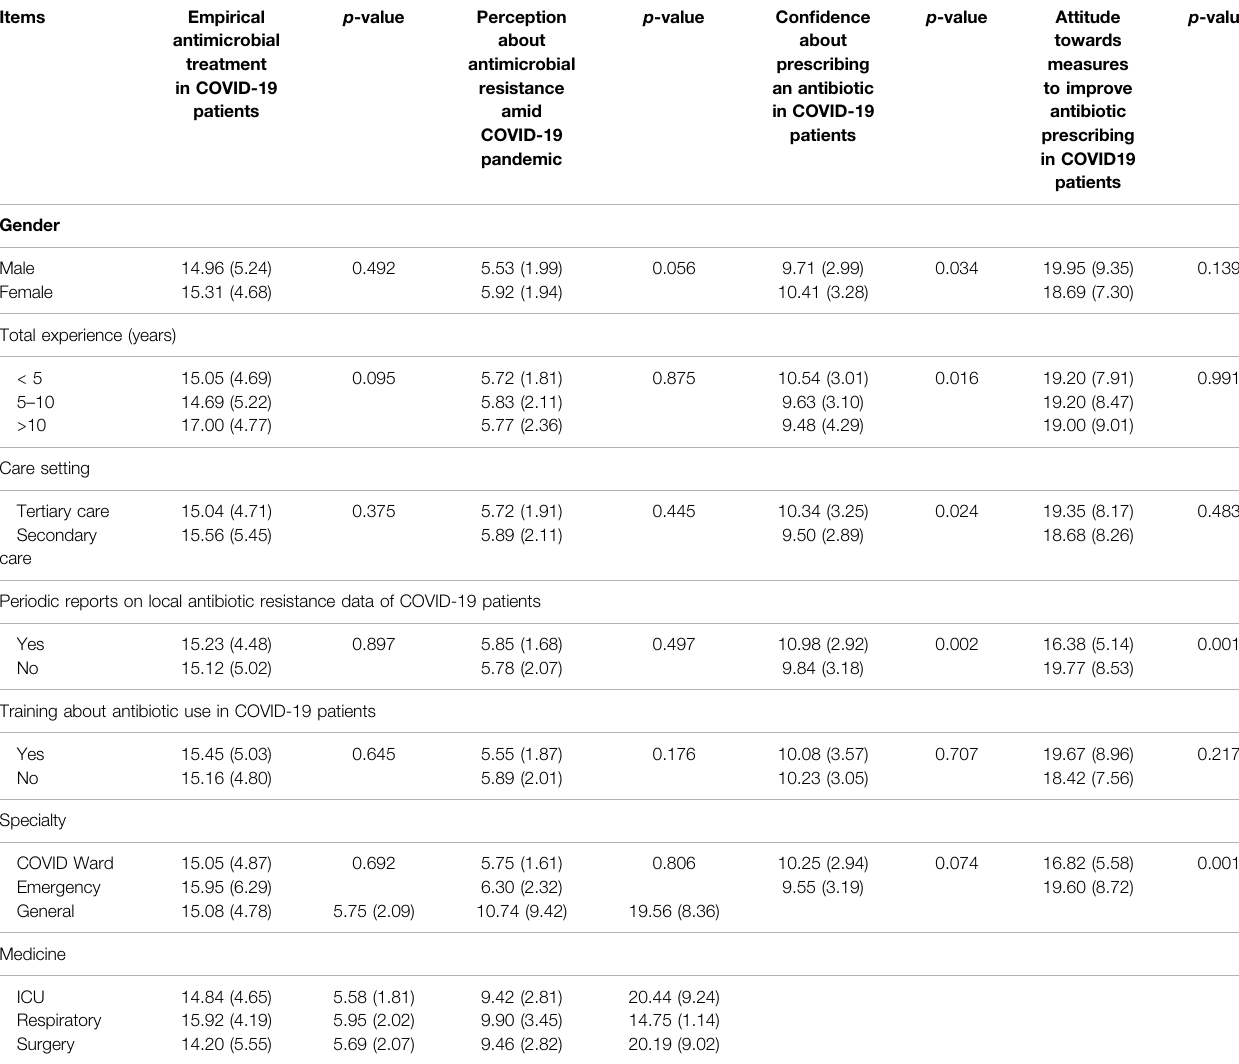
TABLE 3 | Physicians ’ perception and attitudes towards empirical antimicrobial use in COVID-19 patients, by gender, experience, hospital type and training.